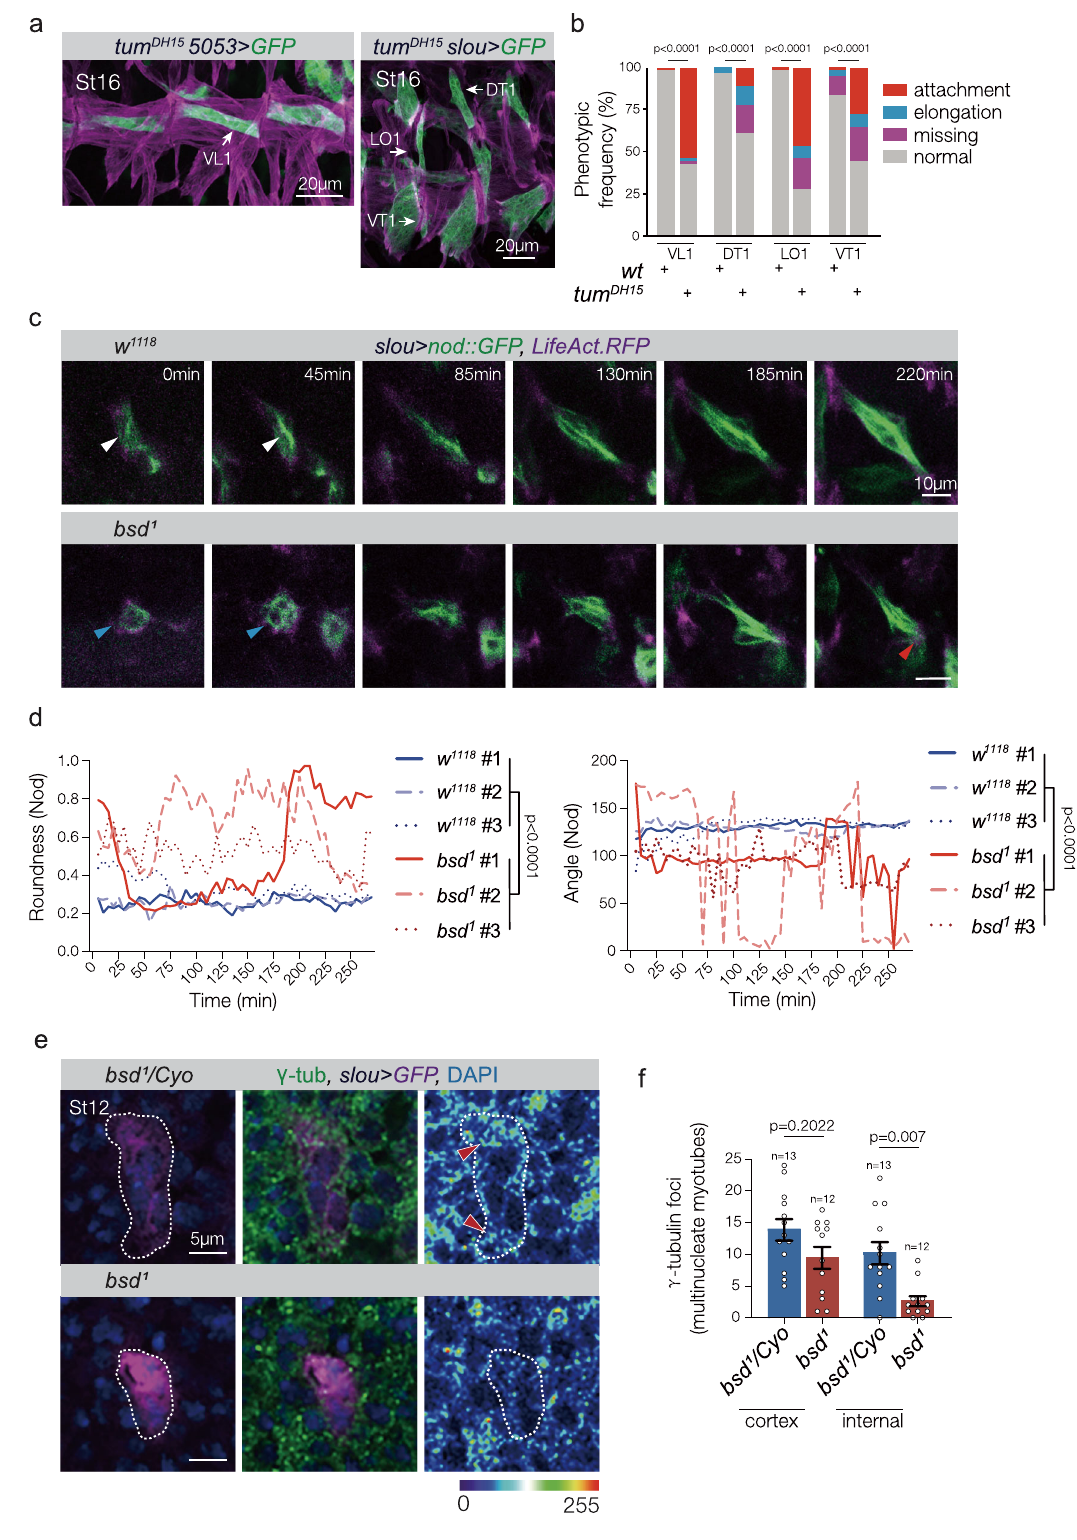
Phenotypic scoring, analysis, and visualization . Each embryonic hemisegment has 30 distinct muscles with a fi xed pattern as shown in Fig. 1b. Muscle phenotypes were analyzed in hemisegments A2 – A7, in a minimum of nine embryos per genotype. For global muscle analyses, a Tropomyosin antibody was used to visualize all 30 muscles. For individual muscle analyses, GFP was expressed under the control of a muscle-restricted Gal4 driver to visualize a subset of muscles. For both assays,